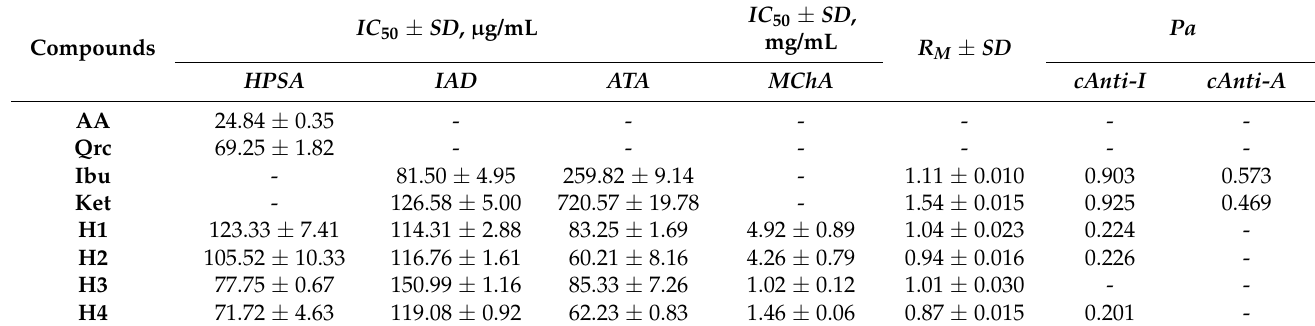
Table 1. Biological evaluation findings from in vitro and in silico. The IC 50 values are expressed for the following activities—hydrogen peroxide-scavenging activity ( HPSA ), inhibition of albumin denat- uration ( IAD ), metal-chelating activity ( MChA ), and anti-tryptic activity ( ATA ). As reference points, ascorbic acid (AA), quercetin (Qrc), ibuprofen (Ibu), and ketoprofen (Ket) were used. Lipophilicity ( R M ) is a non-dimensional quantity because it is acquired via thin-layer chromatography and is a func- tion of Rf . The terms “calculated anti-inflammatory activity ( cAnti-I )” and “calculated anti-arthritic activity ( cAnti-A )” are expressed as P a (probability “to be active”), and assess the likelihood that the investigated molecule is a member of the sub-class of active compounds (resembles the most typical molecular structures in a subset of “actives” in the PASS training set). The molecule with the highest level of activity has a value of 1. H1–4 —furan